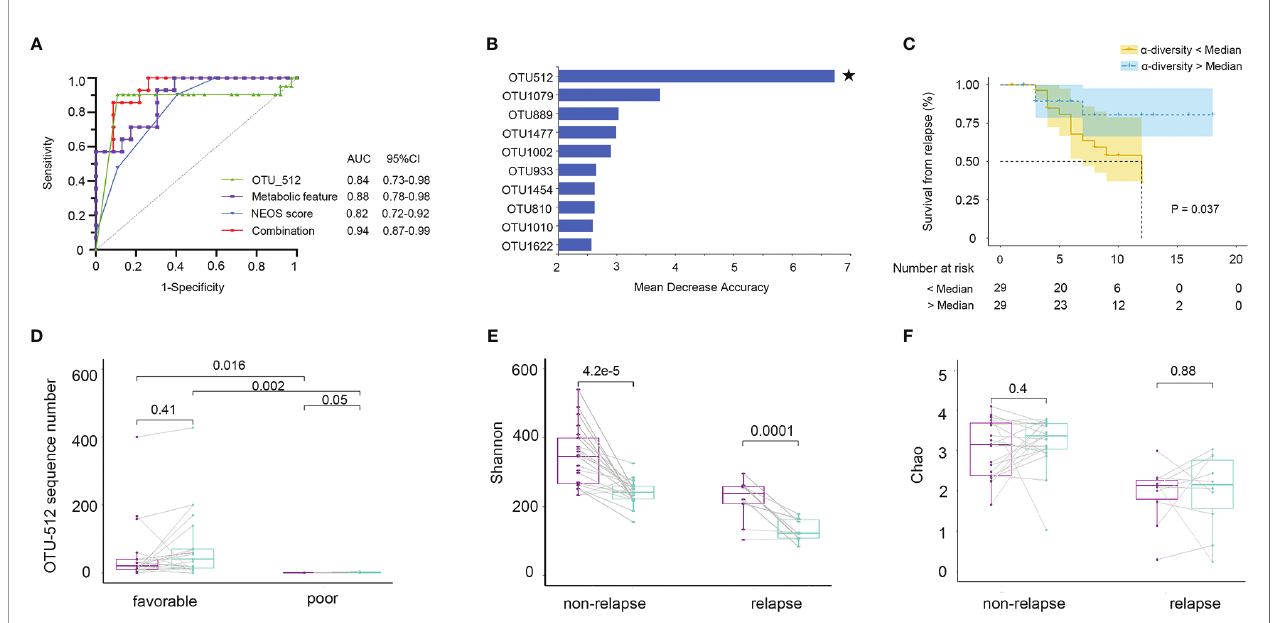
FIGURE 8 | Fecal microbiota and outcomes in anti- N -methyl- D -aspartate receptor (NMDAR) encephalitis patients. The community composition of fecal bacteria was signi fi cantly predictive of functional outcomes at 6 months. (A) Diagnostic outcomes are presented via receiver operating characteristic (ROC) curves for the outcomes at 6 months of NMDAR encephalitis patients. (B) Detailed explanatory variables that are based on random forest models for comparison of favorable and worse outcomes. Bar lengths in the histogram denote the mean decrease accuracy, showing the signi fi cance of operational taxonomic units (OTUs) for classi fi cation. Random forest identi fi ed the fecal-associated OTU512 ( Granulicatella ) as the strongest predictor of favorable outcome. (C) Cox proportional hazards model of the association of relapse. Patients were grouped into two: a -diversity < median and a -diversity > median, for which at least 6-month Kaplan – Meier survival plot is shown. Fifty-eight NMDAR encephalitis patients were grouped based on Shannon index median (log-rank p = 0.037, HR = 2.74, 95%CI = 1.06 – 7.05). Numbers below the curve represent the at-risk patients per group. Yellow line , below the median; blue line , above the median. Analyses were done using quantitative values, and grouping by quantiles was used for graphical presentation only. Patients with unfavorable outcomes did not improve microbiota abnormalities compared to patients with favorable outcomes. (D) Patients with paired baseline and long-term (6 ± 1 months) fecal samples are represented ( n = 30). The measured parameters were genera OTU512. (E, F) Patients without relapse had an overall improvement of the Shannon and Chao indices over time compared to patients with one or several relapses. Wilcoxon signed-rank test for comparisons of paired baseline and long-term